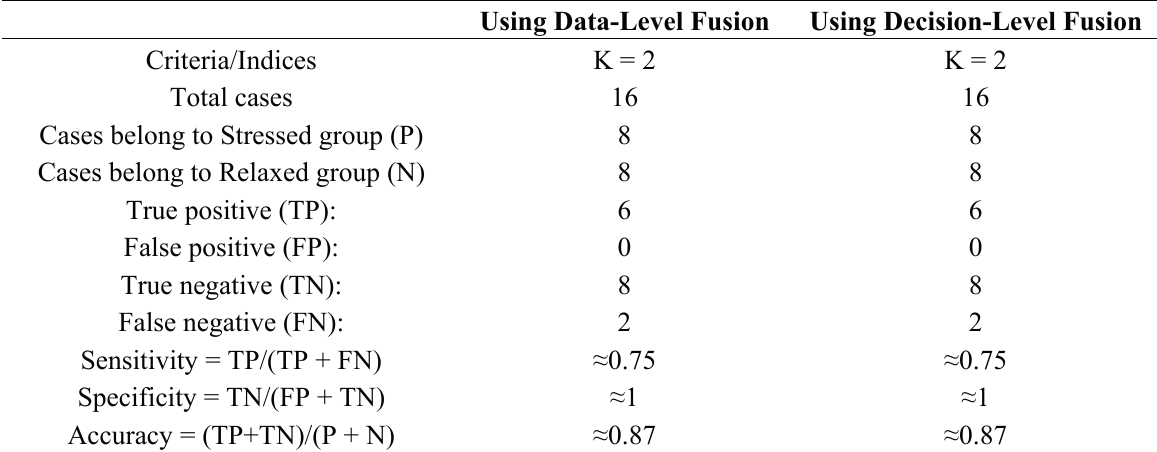
Table 7. A comparison of the data-level and decision-level fusion based on statistical analysis of the